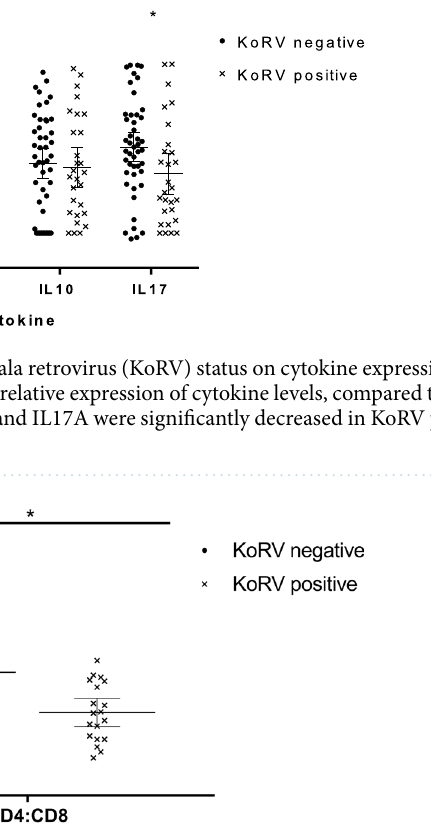
Figure 2. Effect of KoRV infection on CD4:CD8 expression ratio of KoRV negative (left, n = 20) vs KoRV infected (right, n = 19) koalas. Geometric mean (line) and 95% CI of the geometric mean for CD4:CD8 relative expression ratio calculated from CD gene expression relative to reference genes calculated using the Δ Cq method 67 . The CD4:CD8 expression ratio is significantly lower in koala retrovirus (KoRV) positive koalas ( * p < 0 . 05 , T test with Welch’s correction for uneven variance), and less